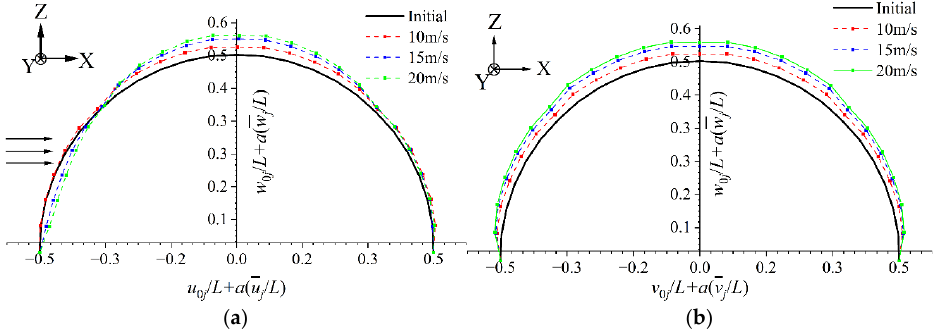
Figure 12. Mean deformation profiles in different sections (amplification coefficient a =5): ( a ) XZ ‐ plane; ( b ) YZ ‐ plane.